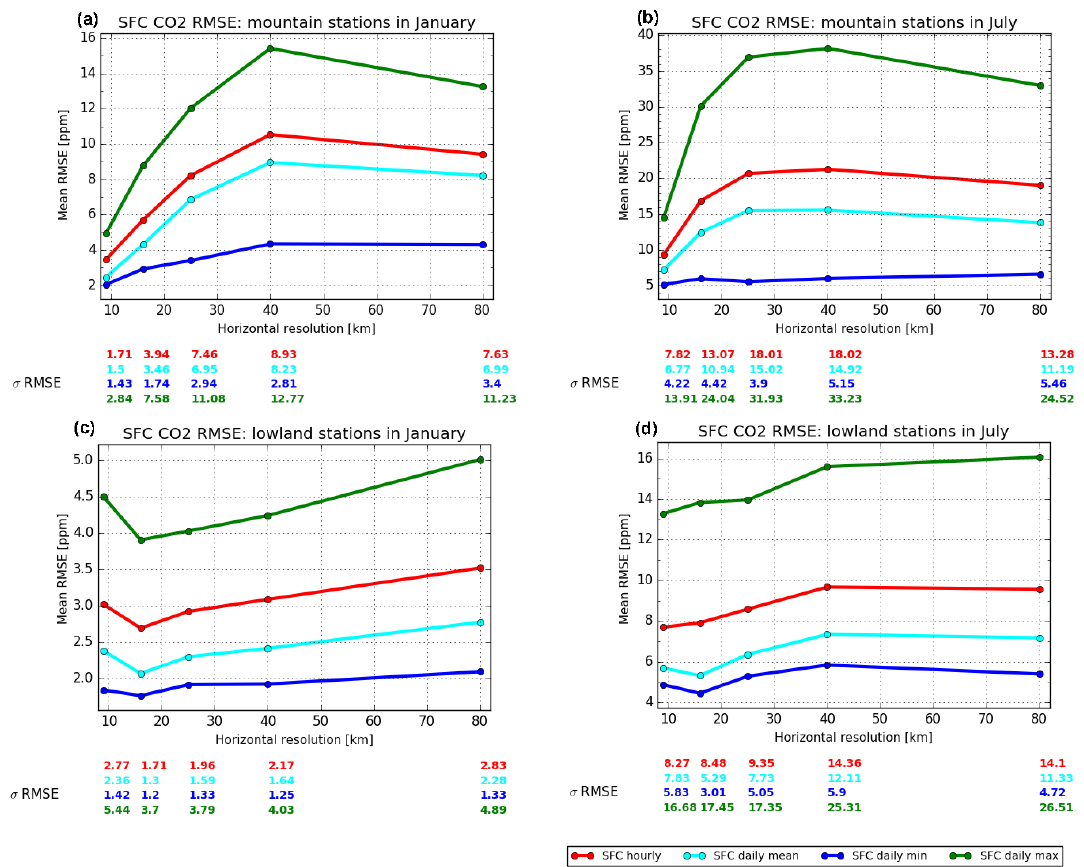
Figure 6. Mean RMSE of near-surface CO 2 (ppm) at different model resolutions in January (a, c) and July (b, d) for (a, b) 37 lowland stations (below 1000ma.m.s.l.) and (c, d) 12 mountain stations (1000ma.m.s.l., excluding bao and spo, as listed in Table A1). The standard deviation of the plotted variable from each station is shown by the numbers below the horizontal resolution for each temporal resolution (hourly, daily mean, daily min and daily max). All the model simulations are based on the 1d forecast. Note that different scales are used in each